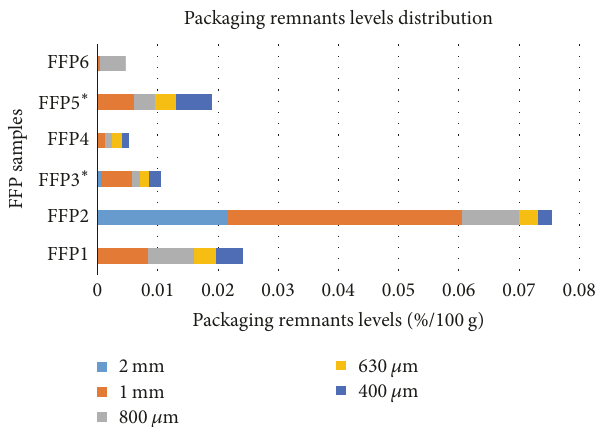
Figure 1: Packaging remnants contamination (% w/w) in all FFPs samples, divided for different sieve mash fractions. ∗ Pelleted samples (adapted from